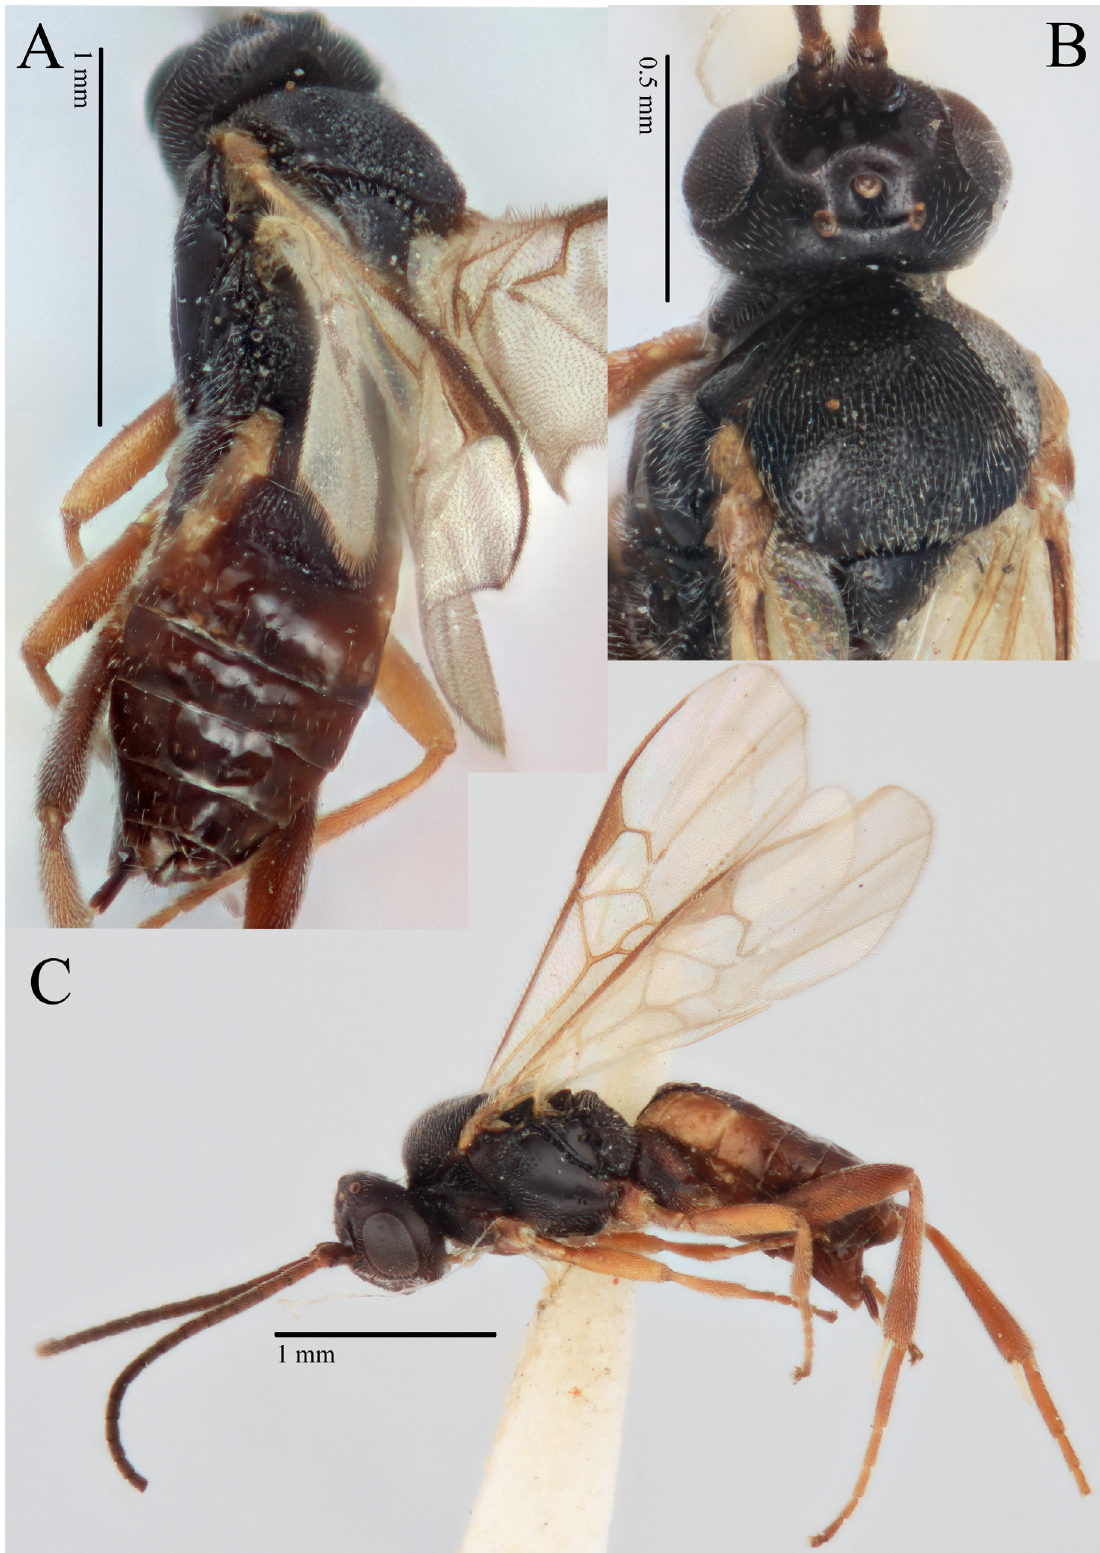
Fig. 24. Cotesia radiantis (Wilkinson, 1929), holotype, ♀ (NHMUK 3.c.1036) A . Metasoma. B . Anteromesoscutum. C . Habitus in lateral